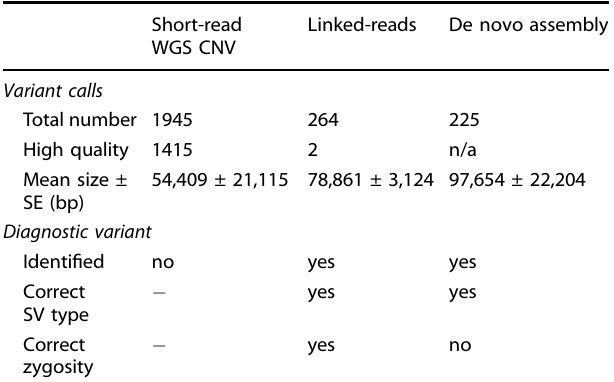
Table 2. Comparison of duplication calls between short-read WGS CNV and genome assembly technologies. Calls for the 32 kb intronic NHEJ1 duplication